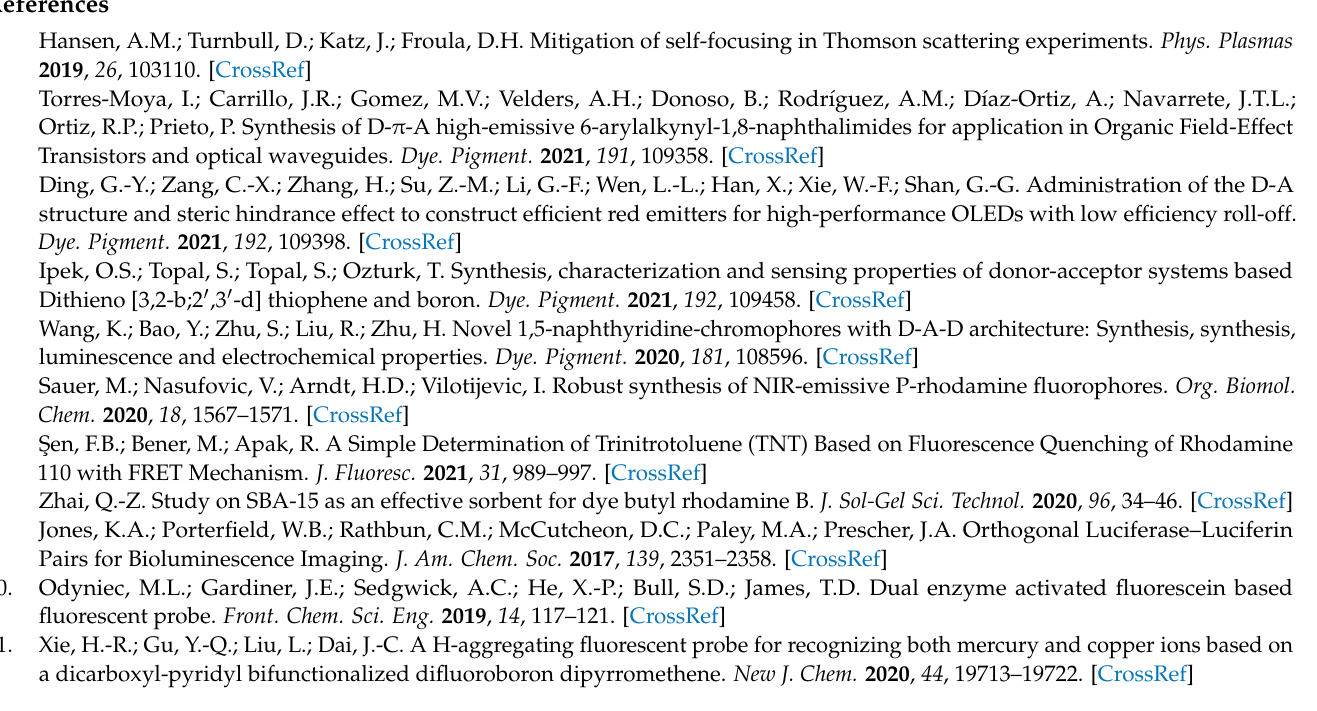
Supplementary Materials: The following are available online. Figure S1: 1 H NMR (400 MHz) of M-1 in CDCl 3 , Figure S2: 13 C NMR (400 MHz) of M-1 in CDCl 3 , Figure S3: 1 H NMR (400 MHz) of M-2 in CDCl 3 , Figure S4: 13 C NMR (400 MHz) of M-2 in CDCl 3 , Figure S5: 1 H NMR (400 MHz) of M-3 in CDCl 3 , Figure S6: 13 C NMR (400 MHz) of M-3 in CDCl 3 , Figure S7: The HR-MS spectrum of M-1 , Figure S8: The HR-MS spectrum of M-2 , Figure S9: The HR-MS spectrum of M-3 , Figure S10: The HPLC spectrum of M-1 under 254 nm and 485 nm, Figure S11: The HPLC spectrum of M-2 under 254 nm and 495 nm, Figure S12: The HPLC spectrum of M-3 under 254 nm and 500 nm, Figure S13: UV absorption spectrum of 50uM M-1 and M-2 in different solvent, Figure S14: Fluorescence emission spectrum of 50 uM M-1 and M-2 in different solvent, Figure S15: The fluorescence decays of M-1 and M-2 in different solvent, Table S1: M-1 spectrum data, Table S2: M-2 spectrum data, Table S3: M-1 average lifetime in different solvents, Table S4: M-2 average lifetime in different solvents, Table S5: M-3 average lifetime in different solvents, Table S6: M-1~3 average lifetime in BSA, Table S7: M-3 average lifetime in PEG. Table S8: The xyz coordinates of the optimized geometry at